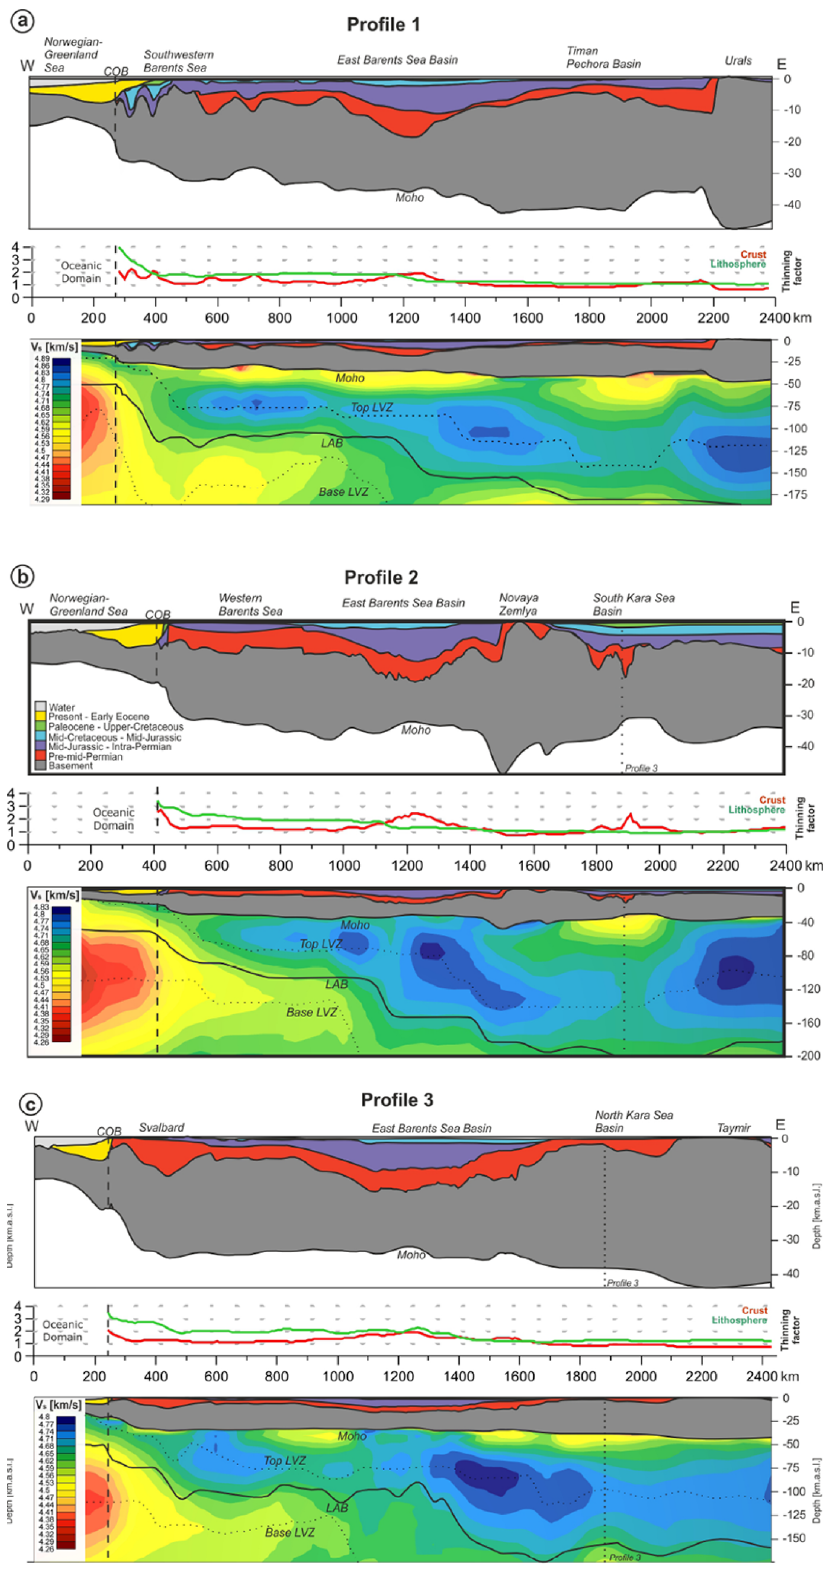
Solid Earth, 6, 153–172, 2015